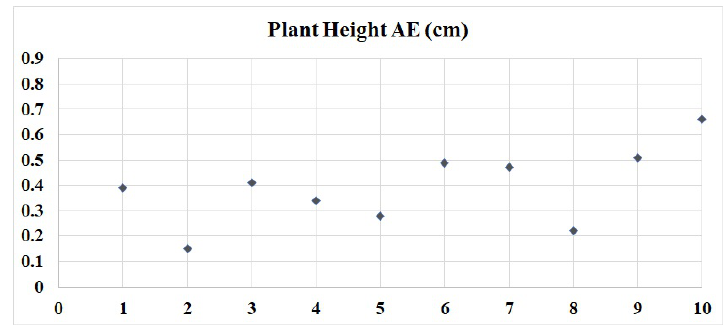
Figure 13. Values of absolute error (AE) for plant’s